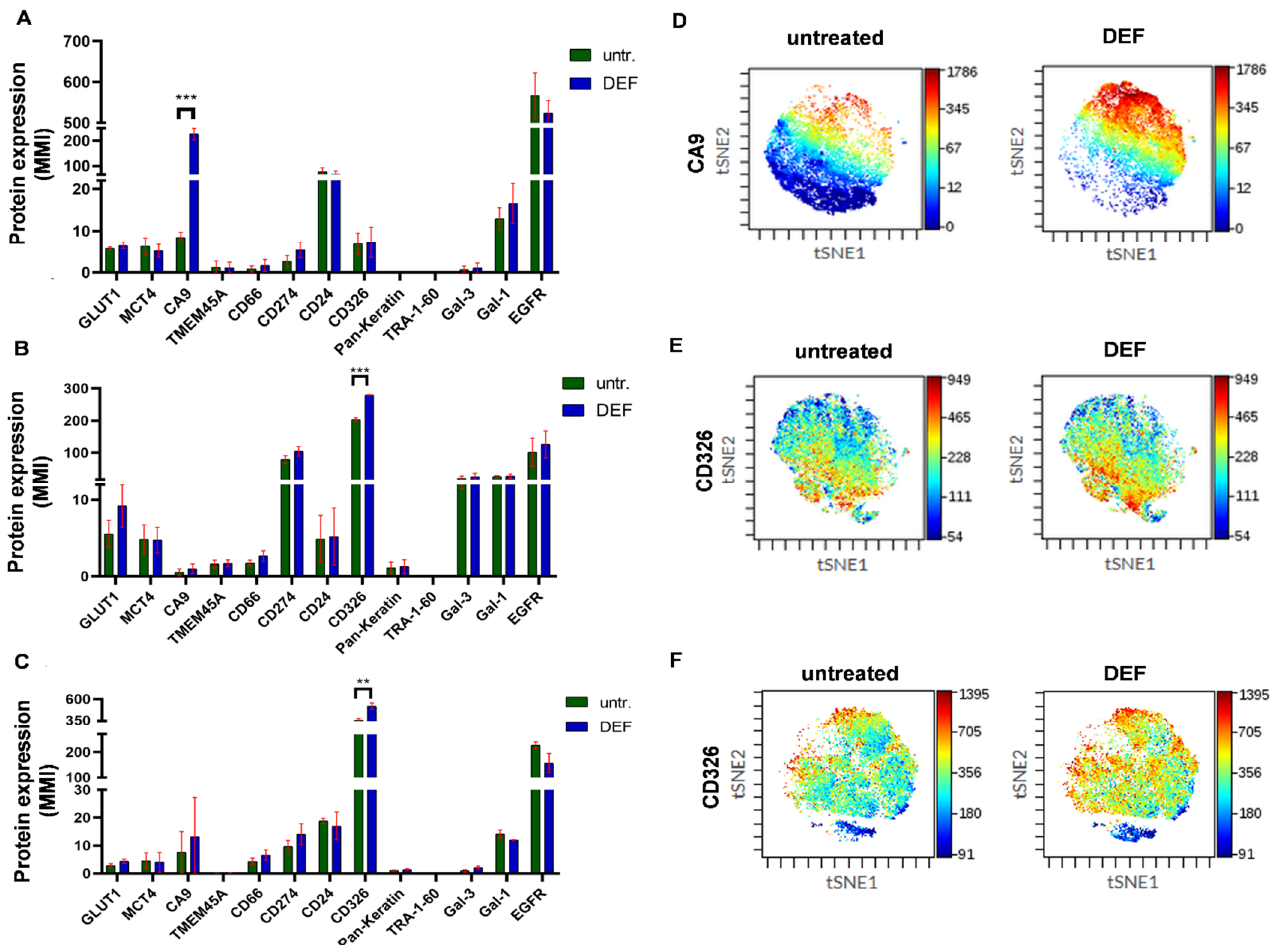
Figure 5. The heterogeneity of A549, H1975, and H1650 human NSCLC cells was preserved after mimicking hypoxia. Column bars of the ( A ) A549, ( B ) H1975, and ( C ) H1650 cells show the expres- sion intensity (MMI = median metal intensity) of live single cells expressing the given cell surface protein markers after deferoxamine (DEF) treatment or when left untreated (untr.). Thirteen protein markers, GLUT1, MCT4, CA9, TMEM45A, CD66, CD274, CD24, CD326, pan-keratin, TRA-1-60, Gal- 3, Gal-1, and EGFR, were investigated with single-cell resolution provided by the metal-tag-labeled antibodies used for mass cytometry. The viSNE pattern of the expression intensities shows an in- crease upon mimicking hypoxia of the ( D ) CA9 for A549 or CD326 for both ( E ) H1975 and ( F ) H1650. *** p <